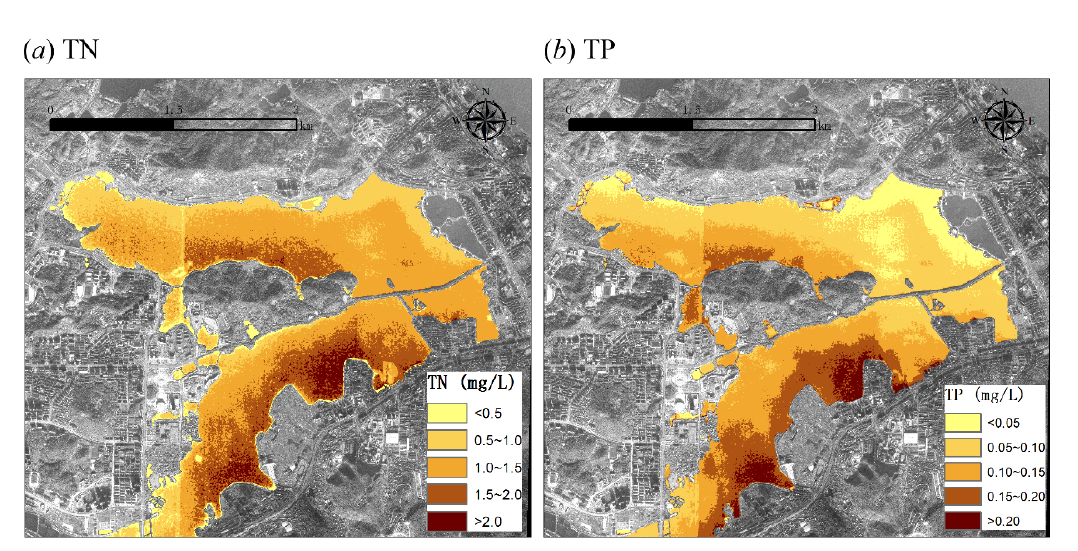
Figure 7. Spatial distribution maps of ( a ) TN and ( b ) TP over Lake